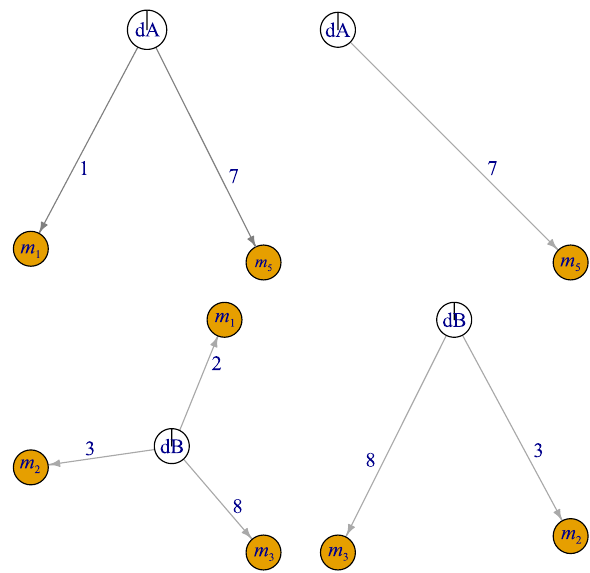
Fig. 2 Examples of mined constrained frequent disease- process subgraphs. Four frequent disease-process subgraphs are shown. The first two are used to diagnose dA, while the last two are used to diagnose